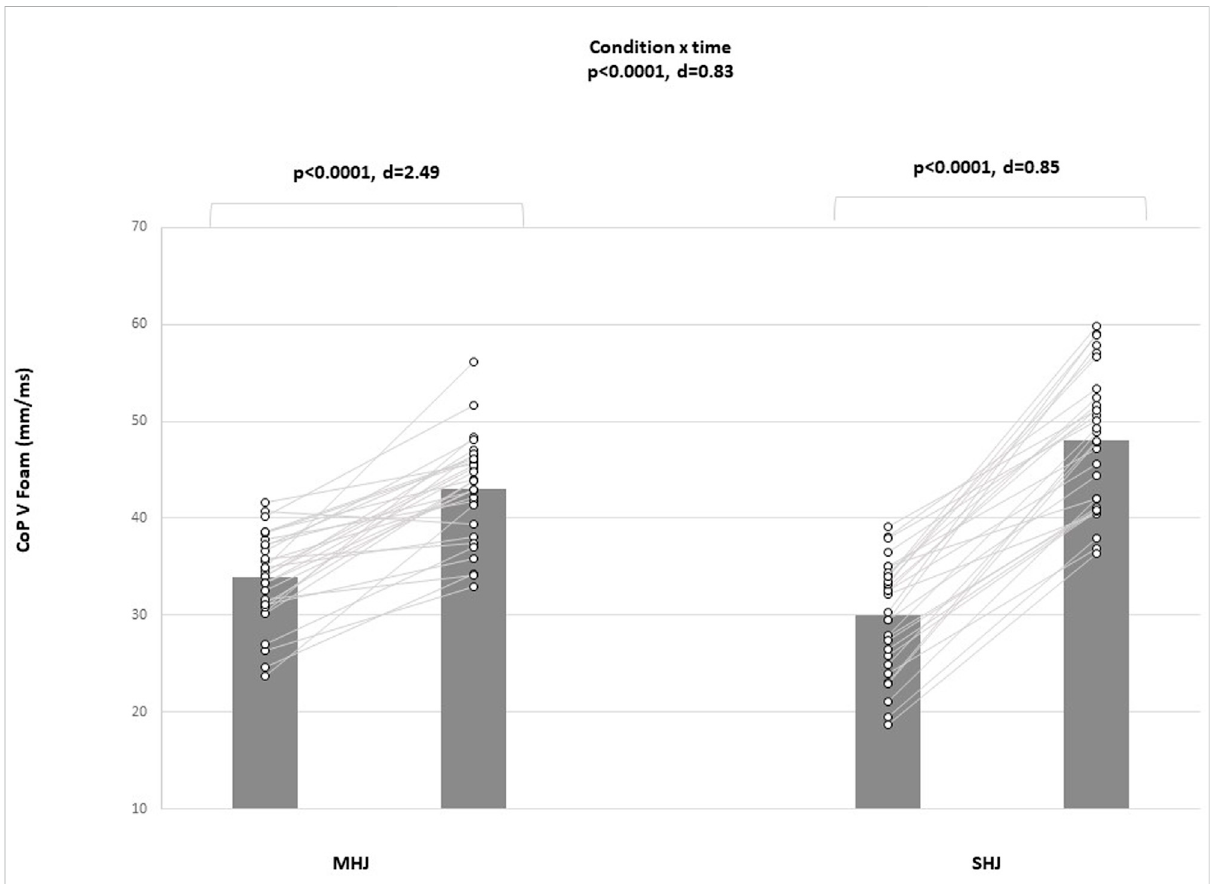
FIGURE 3 Mean values (black) and individual scores (white) for center of pressure velocity on foam surface (CoP V Foam) pre- and post-intervention; d, Cohen ’ s d; MHJ, maximal hurdle jump; SHJ, submaximal hurdle